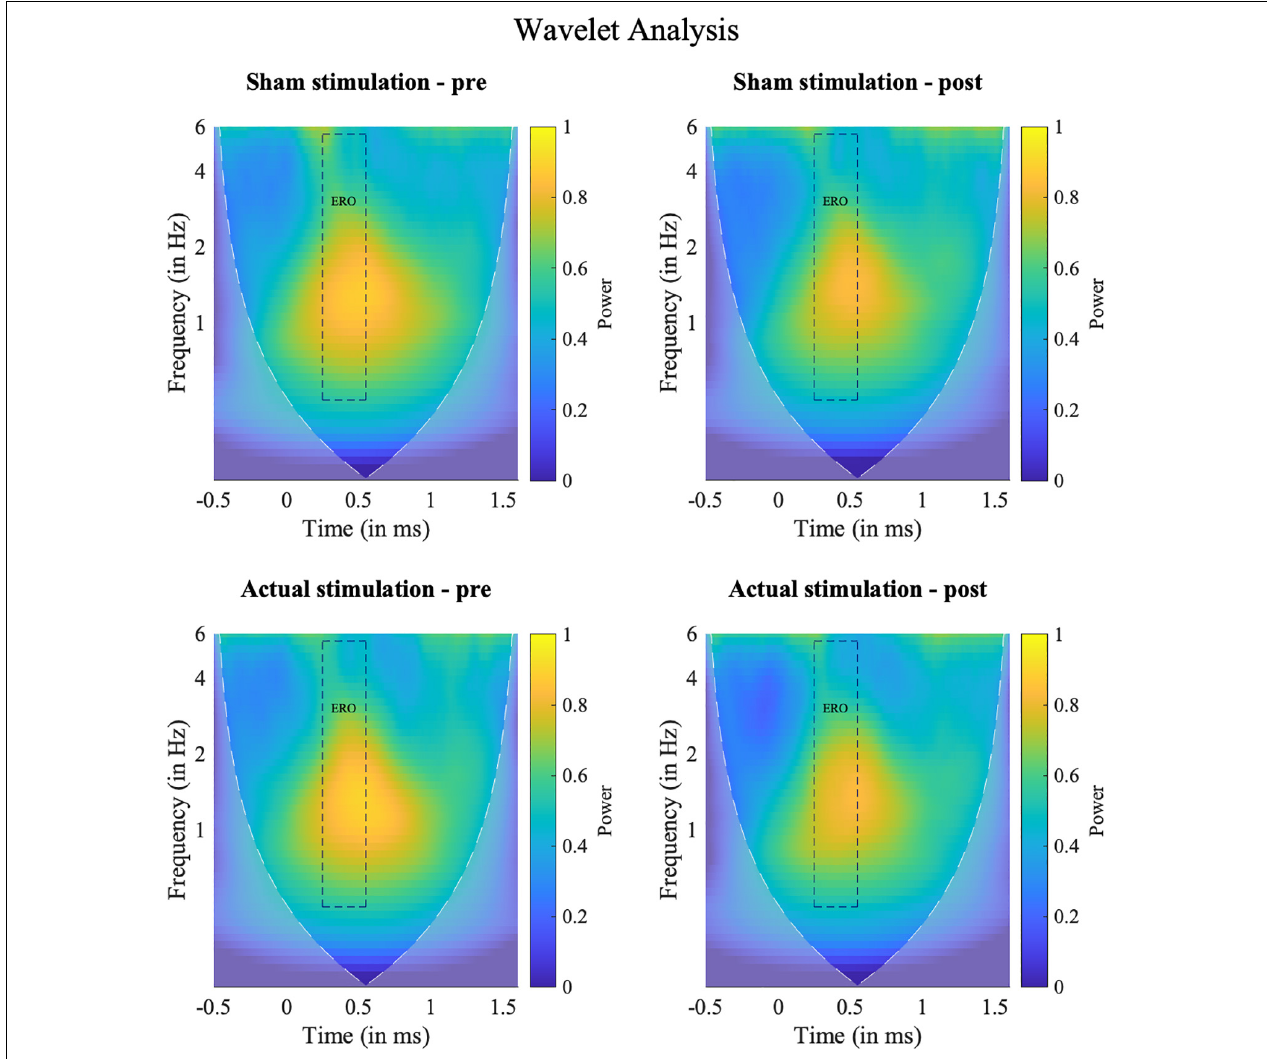
FIGURE 6 | Results of the frequency analyses. Time-Frequency spectra of the wavelet analyses for target hits for the ERO between 0 and 6 Hz at electrode Pz (Grand average). Squares indicate the temporal (0.25–0.5 s) and spectral (0.5–5.5 Hz) region of interest used for the statistical evaluation. Shaded areas outline the area where the calculated wavelet power might be distorted due to edge